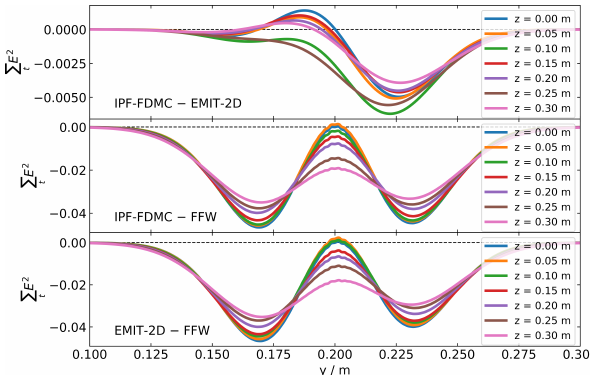
Figure 2. Di ff erence of the detector antenna signals obtained from the full-wave simulations for scenario